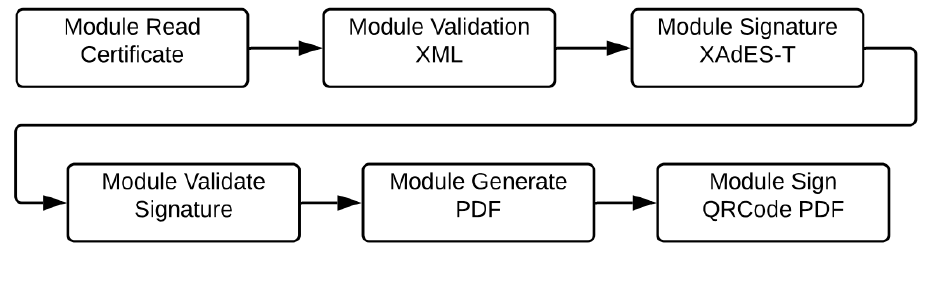
Figure 7. Separation of digital signature process